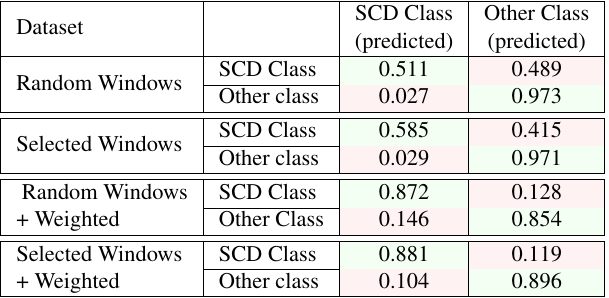
Figure 7. The Random Window dataset (on the left) and the Selected Windows dataset (on the right). Orange and Olive color indicate respectively the validation and the test Area.